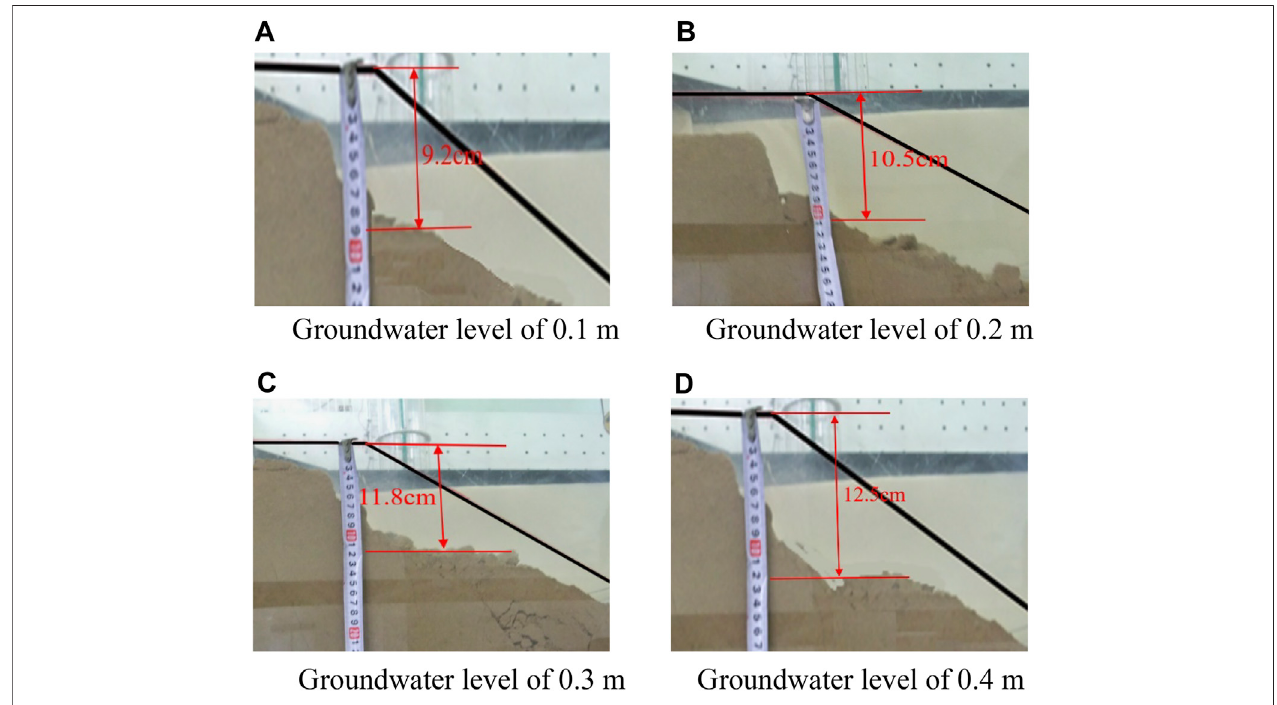
FIGURE 17 | Permanent displacements of the slope. (A) Groundwater level of 0.1 m. (B) Groundwater level of 0.2 m. (C) Groundwater level of 0.3 m. (D) Groundwater level of 0.4 m.